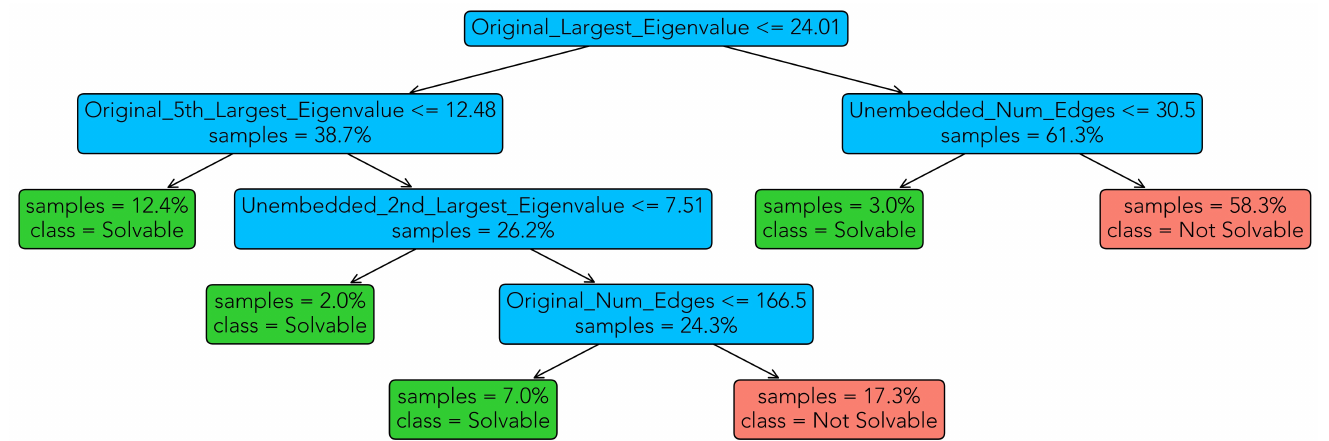
Figure 2. Decision tree for classification of MC instances into solvable and unsolvable, using the features outlined in Section 2. Setting of fixed annealing time and fixed UTC prefactor. Left branches denote true bifurcations, right branches denote false bifurcations. Green leaves are solvable cases, red leaves are unsolvable cases, and inner nodes are colored in